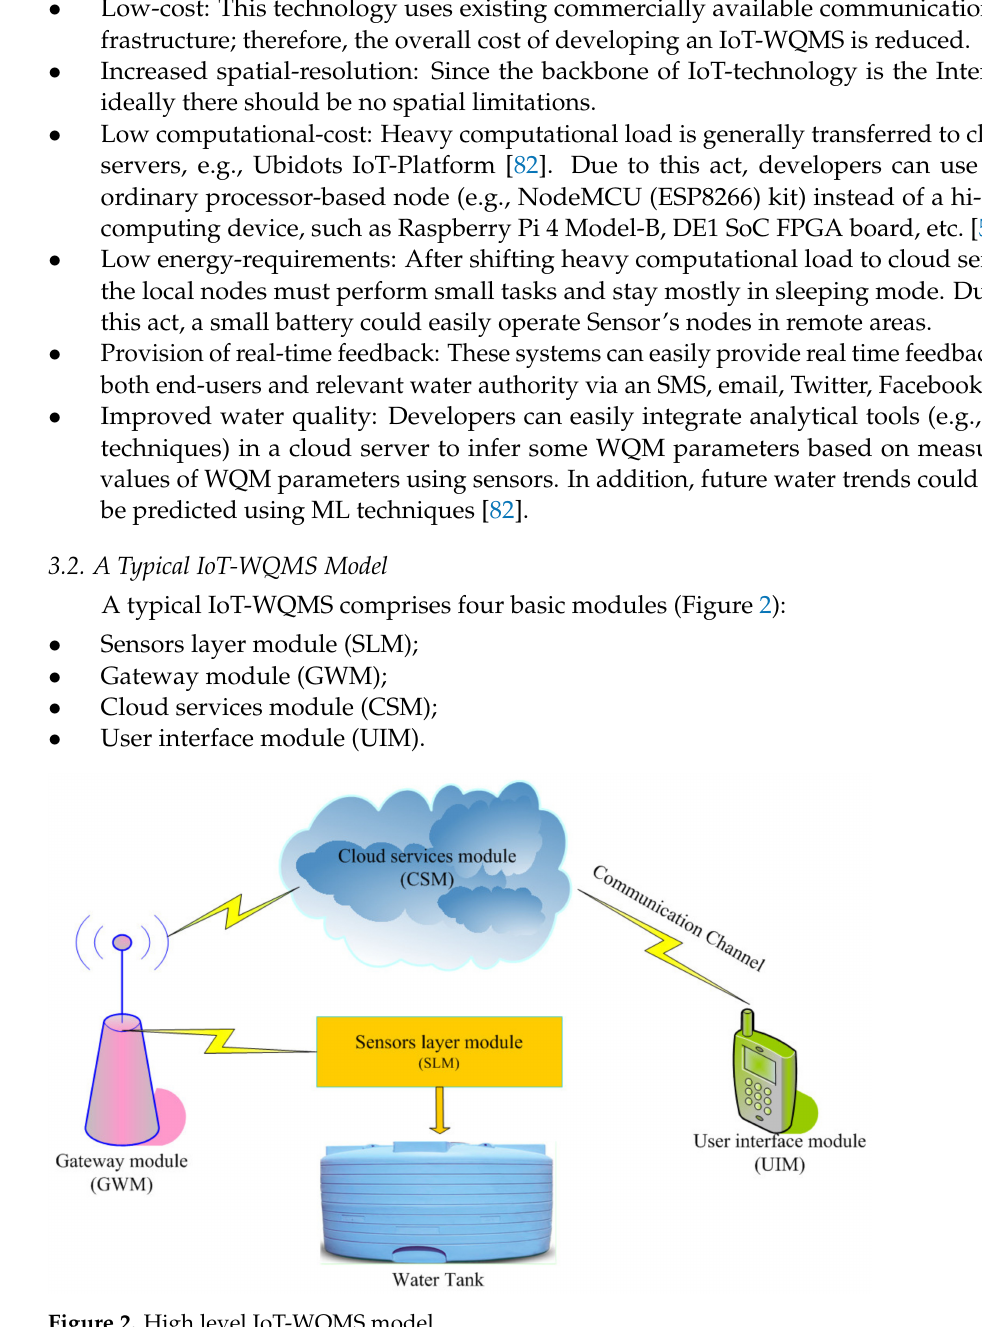
Figure 2. High level IoT-WQMS